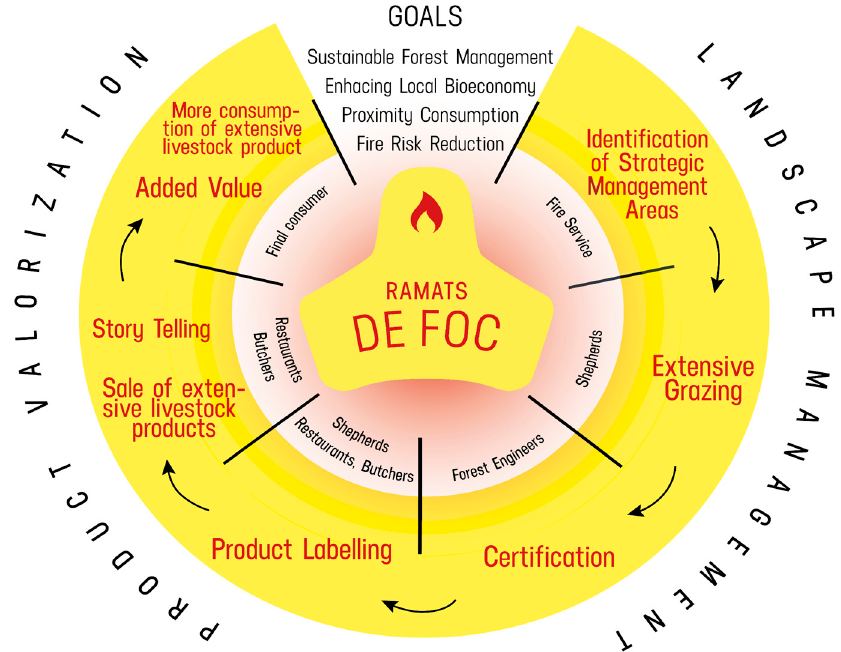
Figure 1. The design and execution process for the Fire Flocks project.